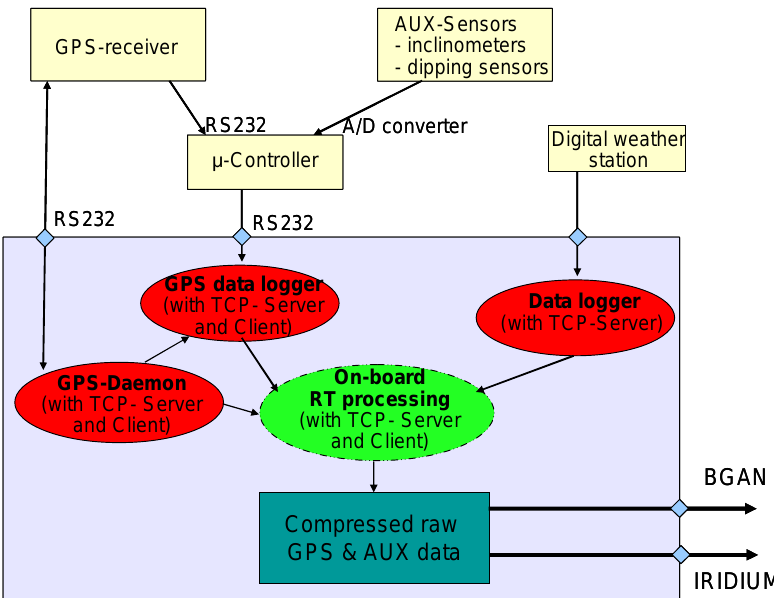
Fig. 4. GPS and auxiliary data flow at the GITEWS buoy. The data streams from the GPS receiver; air pressure, tilt, and dipping sensors are combined directly onboard the buoy creating a compact data format.